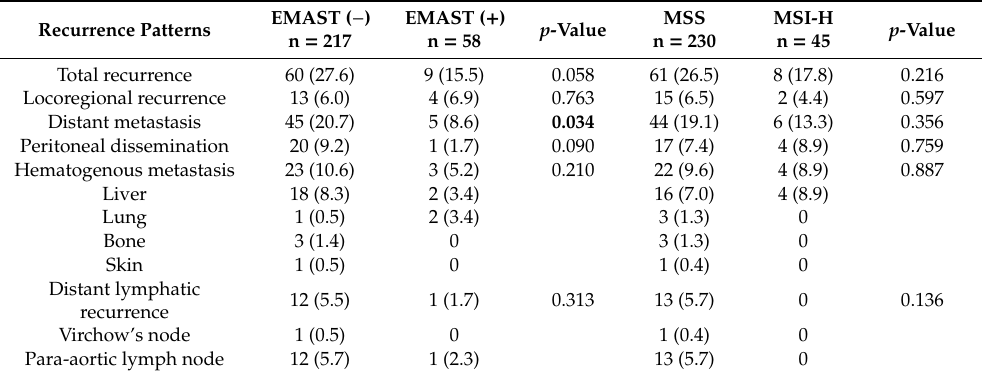
Table 5. The patterns of initial recurrence of gastric cancer after curative surgery, according to EMAST and MSI